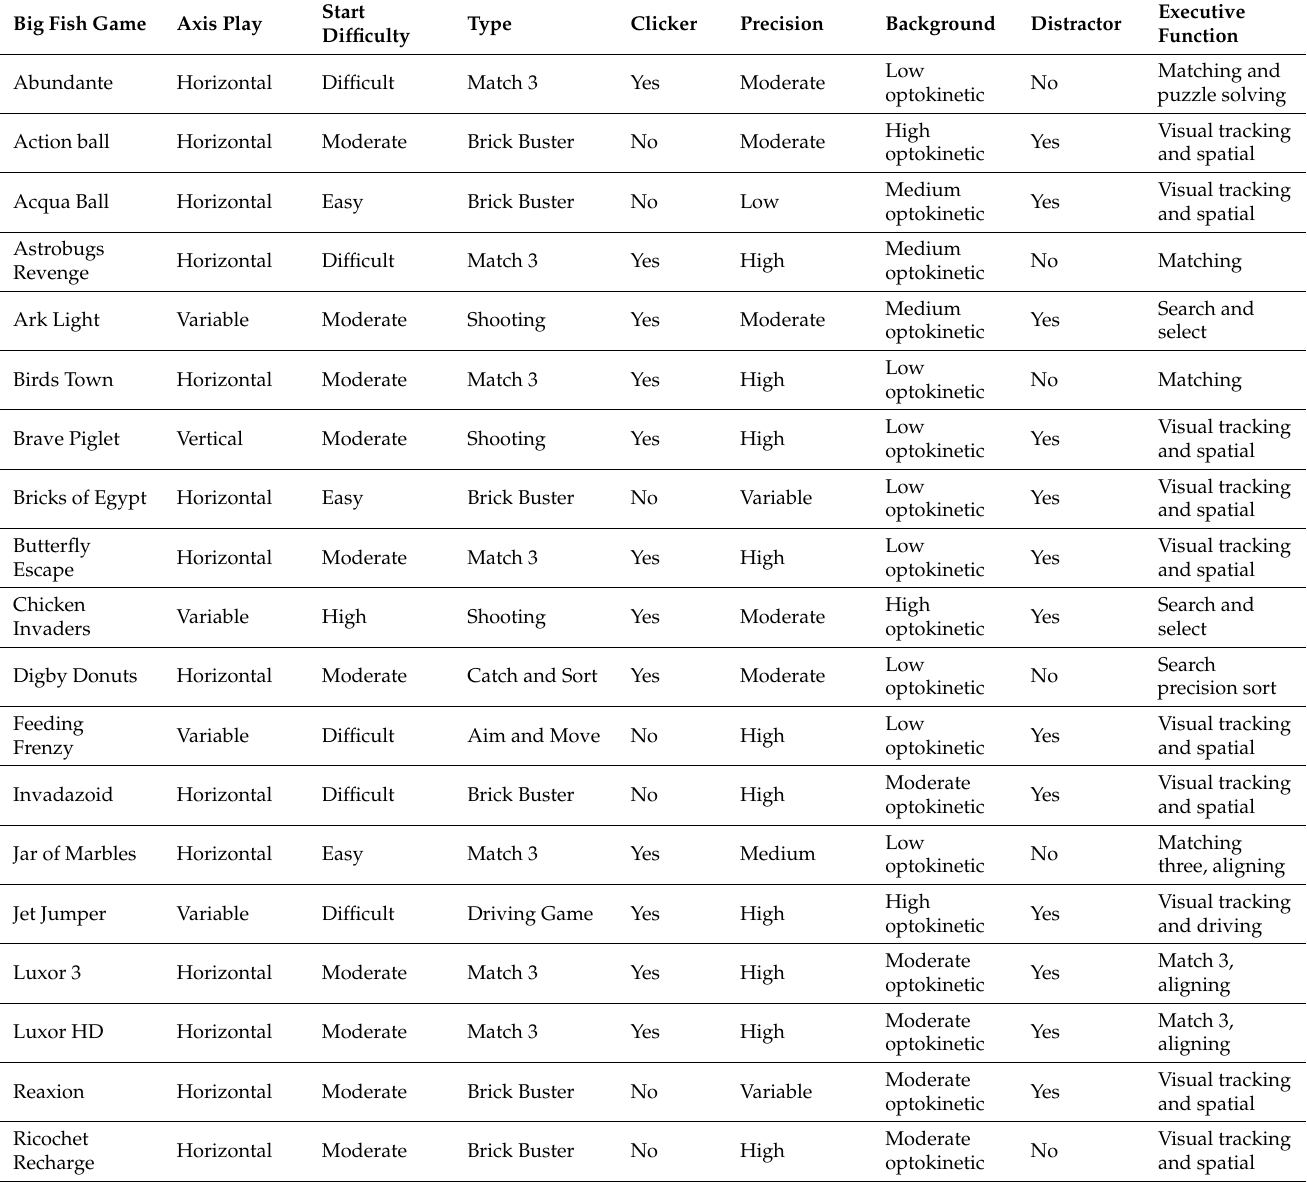
Table A1. List of computer video games used in this study, obtained from www.bigfishgames.com (15 November 2021). Note that matching and shooting games require children to use a small wireless hand-held clicker with a left mouse button to press when needed for game